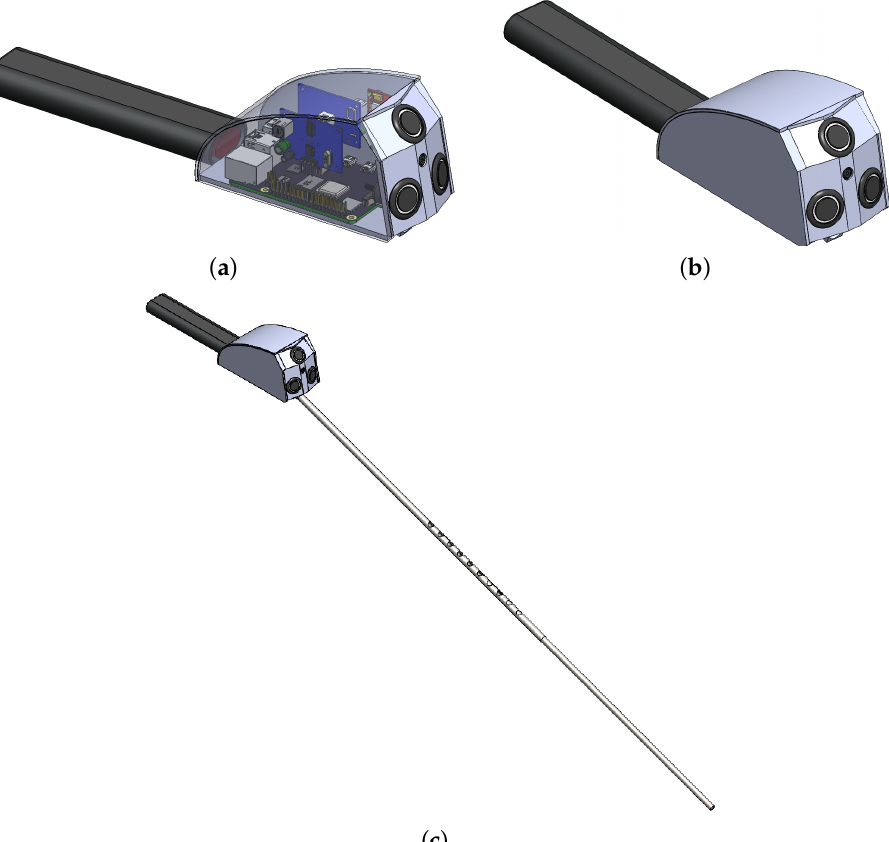
Figure 4. ( a ) Electronic circuitry placement; ( b ) Control box design; ( c ) Design of the adjustable IoT-enabled Intelligent Stick.